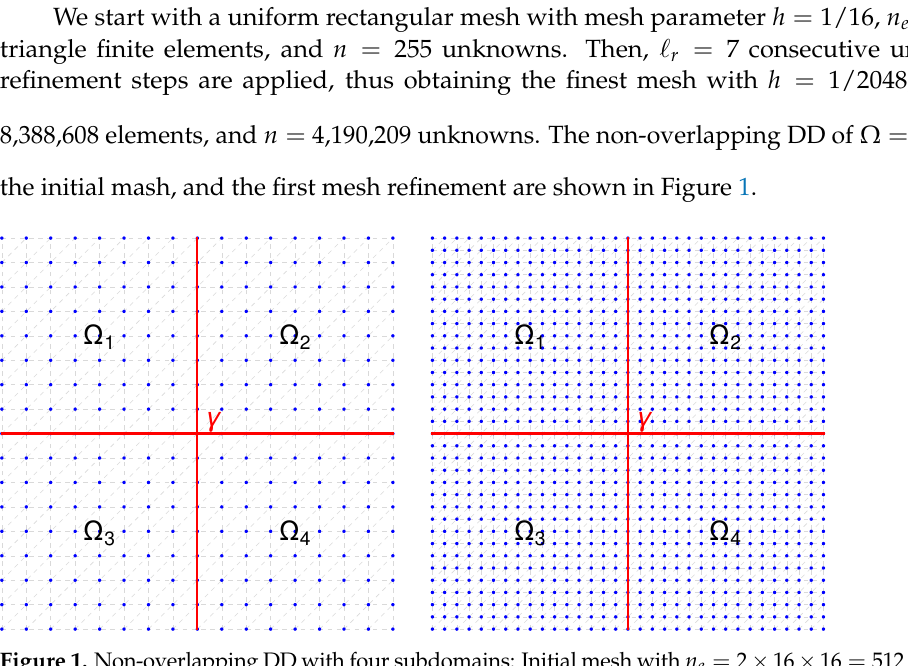
Figure 1. Non-overlapping DD with four subdomains: Initial mesh with n e = 2 × 16 × 16 = 512 finite el- ements ( left ); First step of uniform mesh refinement with n e = 2 × 32 × 32 = 2048 finite elements ( right